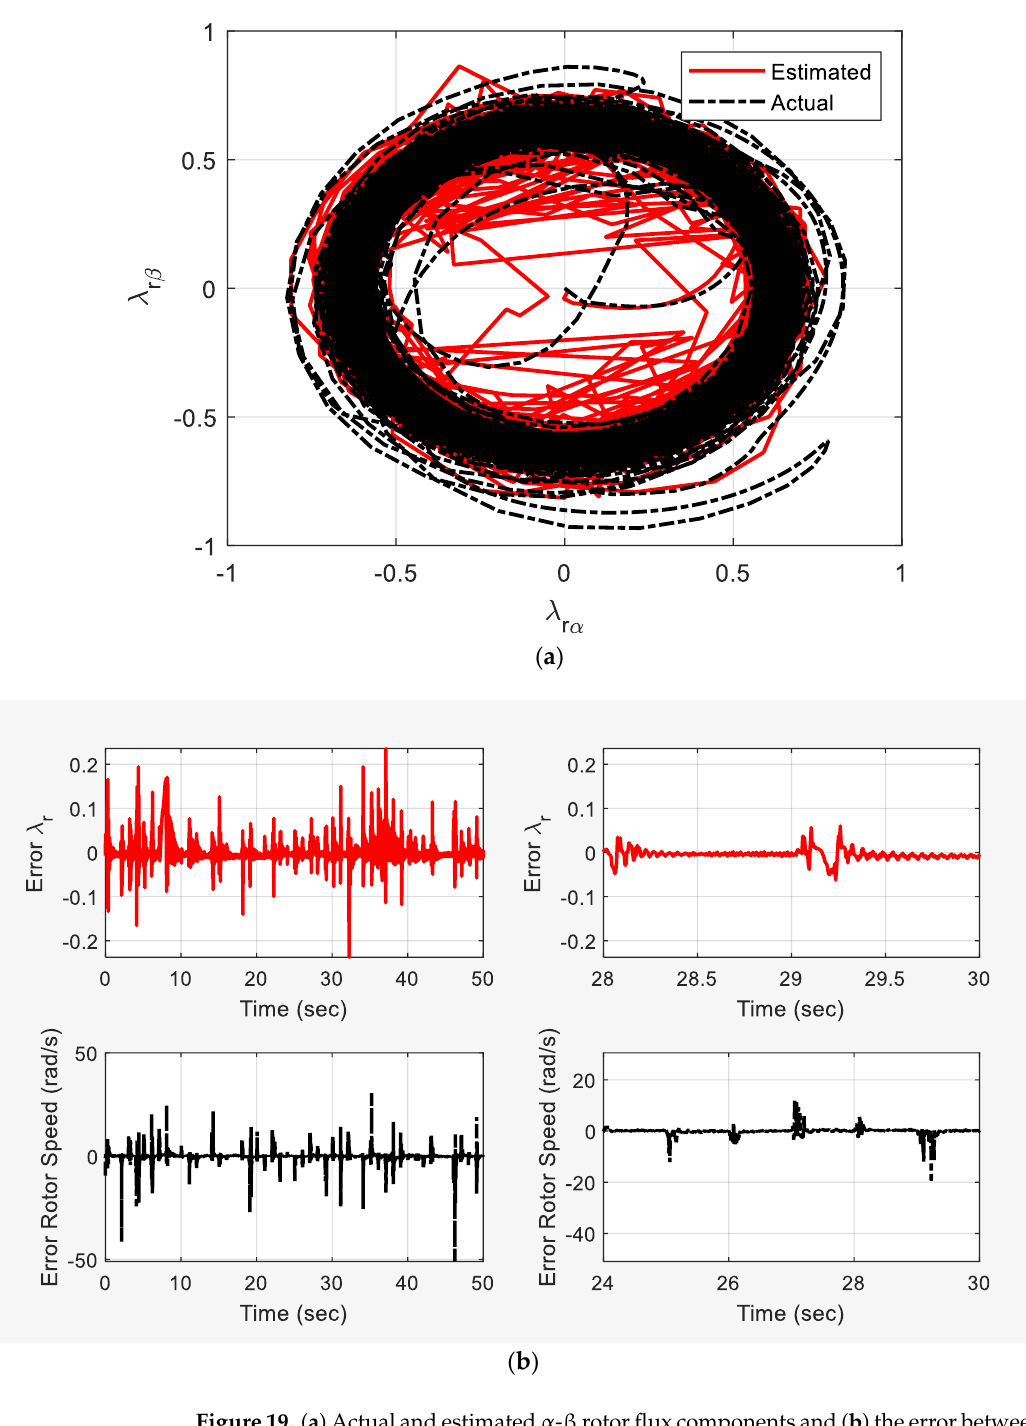
Figure 19. ( a ) Actual and estimated α - β rotor flux components and ( b ) the error between the measured and estimated values of rotor speed and rotor flux.